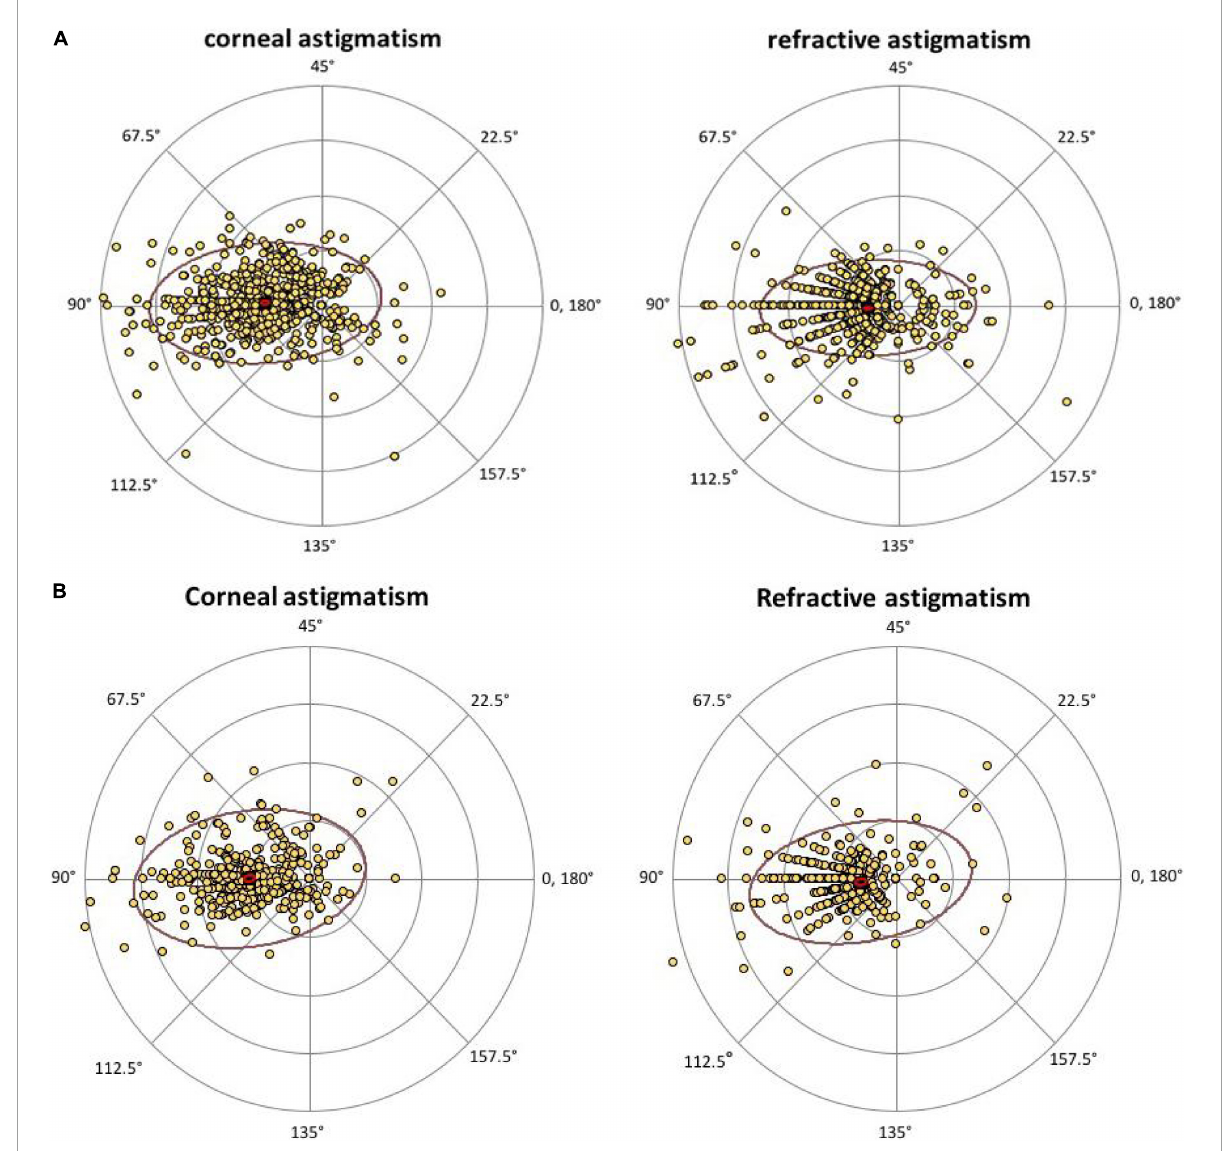
FIGURE1 Double-angle plot of refractive astigmatism and corneal astigmatism in male (A) and female (B) . Data are scattered mostly to the left of the center, indicating that RA and CA tend to have a with-the-rule pattern. RA, refractive astigmatism; CA, corneal